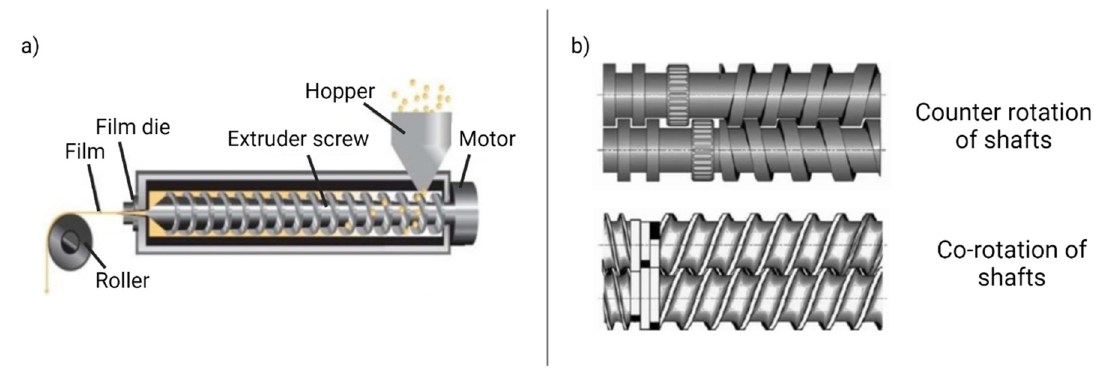
Figure 5. Hot-melt extrusion technique. ( a ) Production of buccal film; ( b ) counter-rotation and co-rotation of shafts (Reprinted with permission from Karki et al. 2016 [57]).